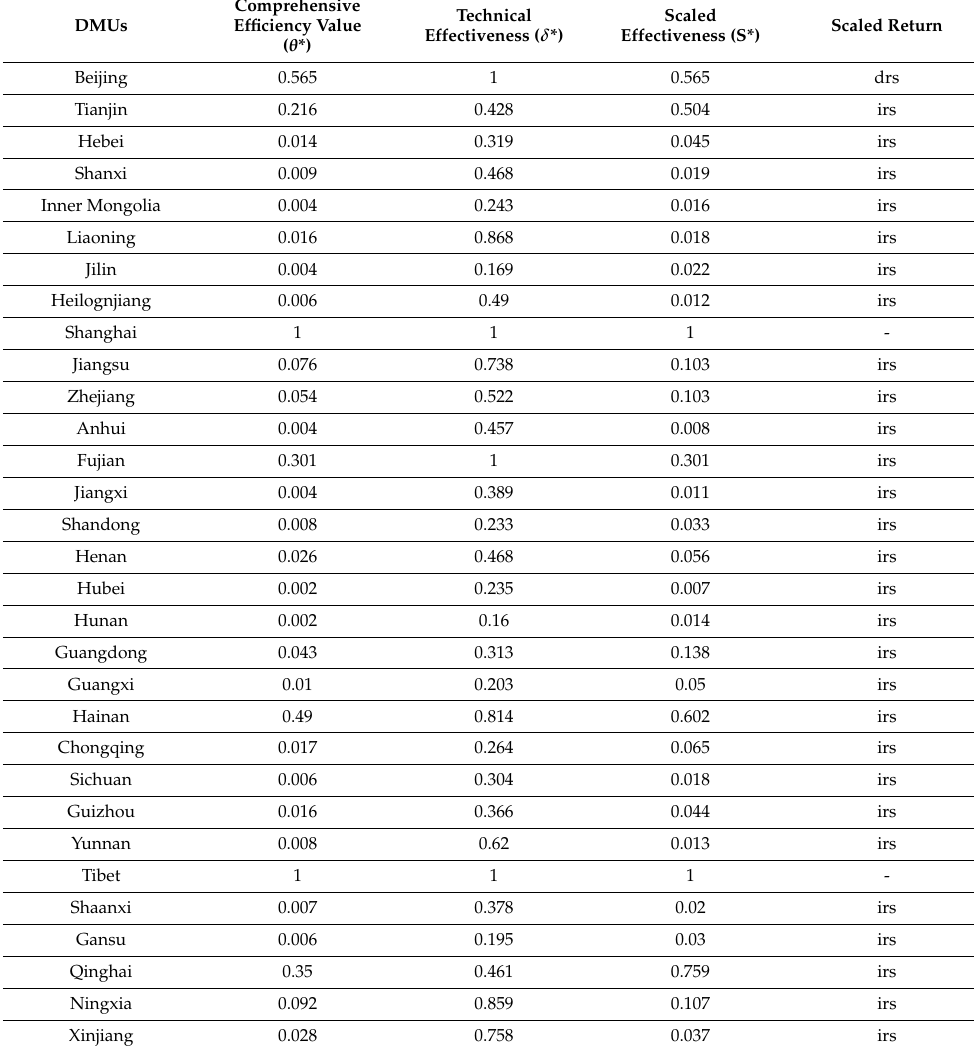
Table 6. DEA efficiency values of natural disaster mitigation and reduction in China in 2020.